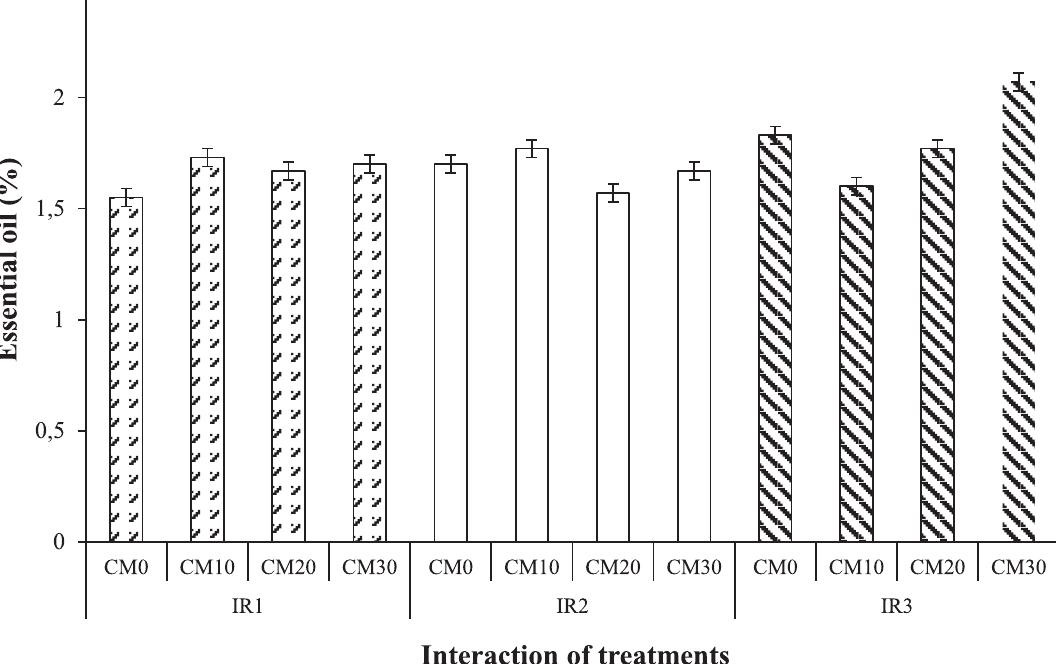
Figure 2 - Effect of irrigation intervals (IR) and cattle manure levels (CM) on essential oil content (%). vertical bars indicate standard errors.